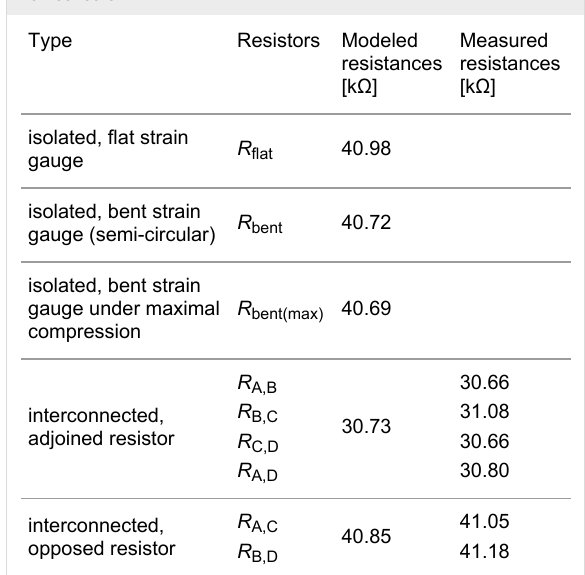
Table 3: Modeled and measured resistances for antiparallel artificial hair